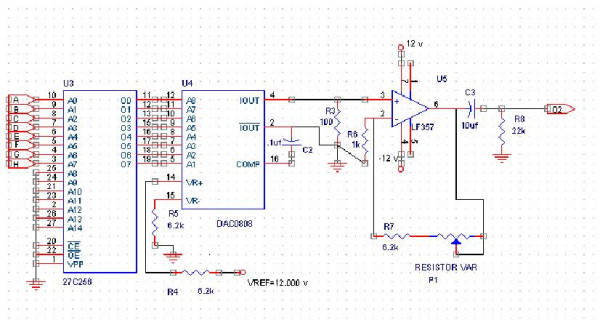
Current Generator.